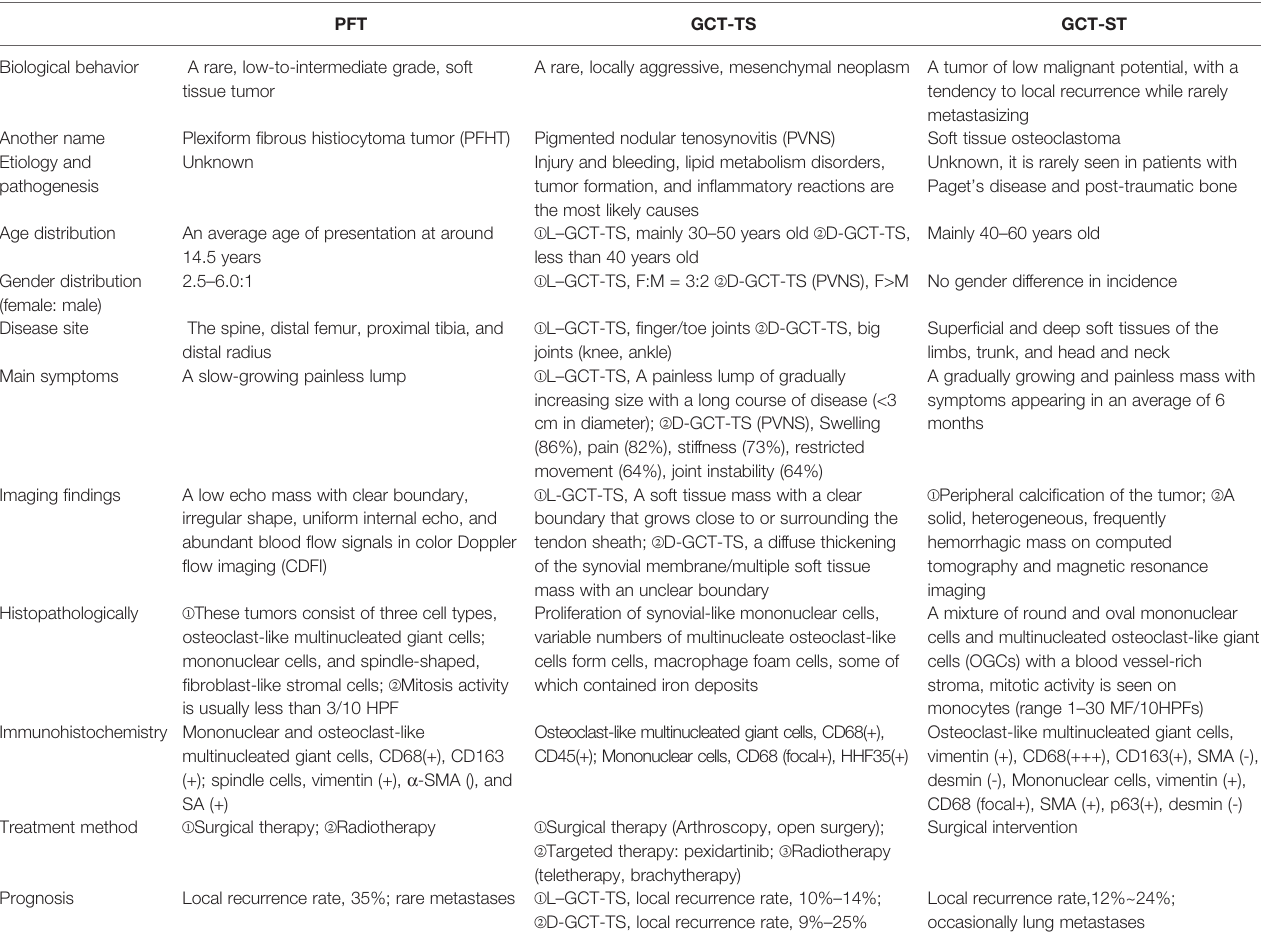
TABLE 3 | Comparison of three different types of tumors.